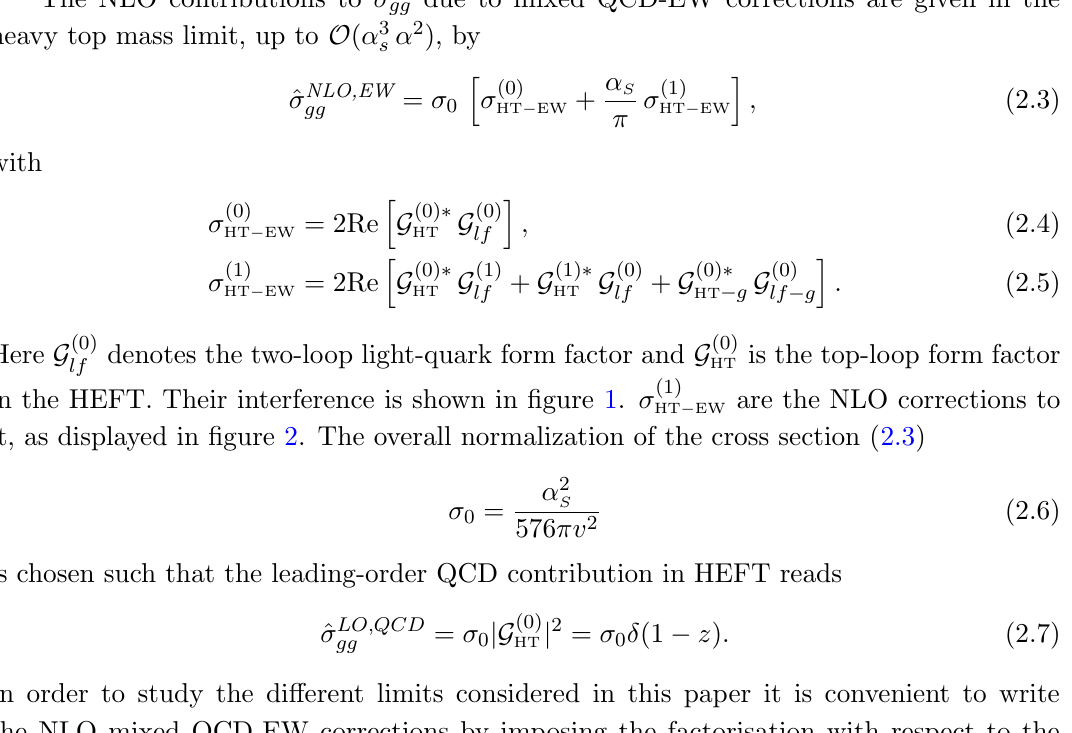
) corrections (2.5) to the S G (0) . Figure 2c: contribution lf HT